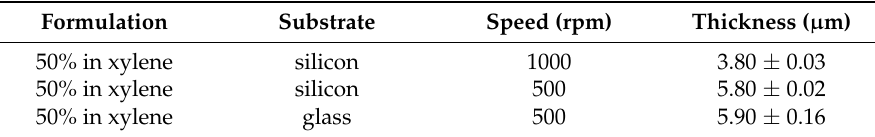
Table 1. Thickness of spin coated Ceraset films.